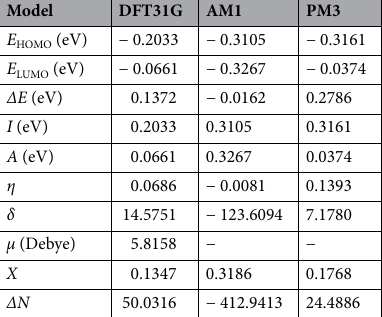
Table 4. The quantum chemical parameters of the APPH inhibitors that were